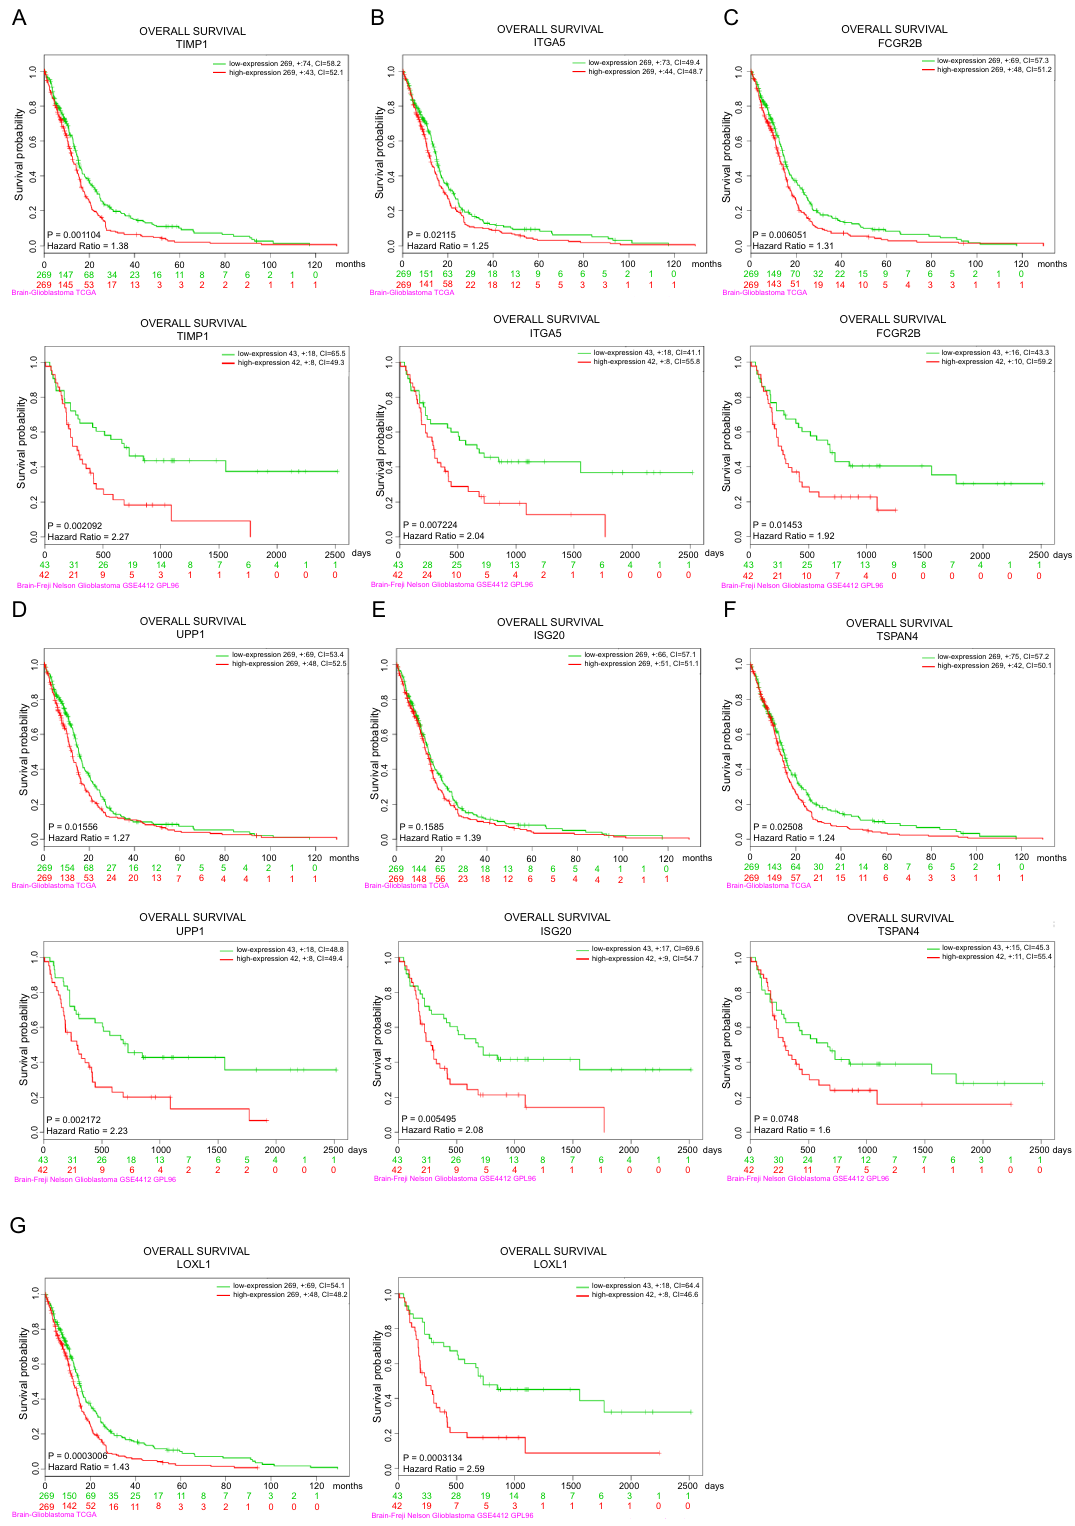
Figure 4. The correlations between the expression of the 7 genes and survival analysis of GBM in different datasets. Correlations between ( A ) TIMP1, ( B ) ITGA5, ( C ) FCGR2B, ( D ) UPP1, ( E ) ISG20, ( F ) TSPAN4, and ( G ) LOXL1 and the overall survival rates of GBM patients in Glioblastoma Multiforme TCGA and GSE4412. The X-axis indicates the time in months or days. Green lines indicate low expression of genes and red lines indicate high expression of genes. The groups between low and high expression of genes were stratified according to the median expression level of these genes. Data were analyzed by log-rank